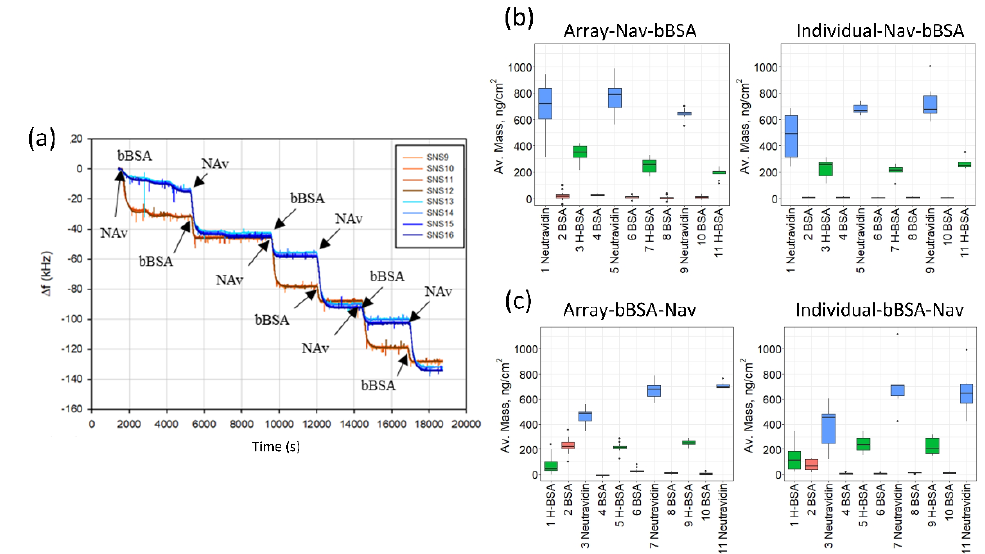
Figure 3. Protein adsorption measurements. ( a ) Frequency changes due to the sequential adsorption of proteins for two columns of the array relative to a baseline in buffer. In one of the two columns (SNS13 to SNS16), proteins were adsorbed in sequence bBSA-Nav- bBSA-Nav- bBSA-Nav, in the other (SNS9 to SNS12) Nav-bBSA-Nav-bBSA- Nav-bBSA. SNSi with i = 9 to 16 refers to the element position on the array according to Figure S1 in the Supporting Information. ( b , c ) Mass changes observed in the experiments performed with arrays ( left ) and individual 50 MHz resonators at the 3rd overtone ( right ) for the two adsorption sequences, respectively. Error bars are standard deviations.